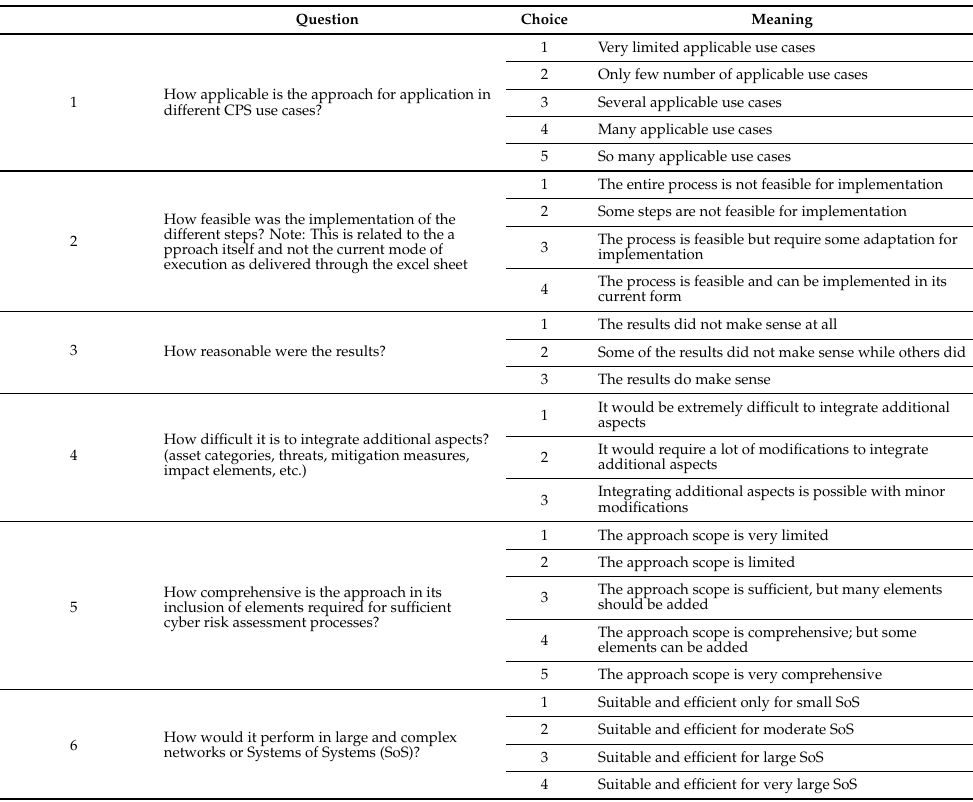
Table A2. Questions and choices used for expert